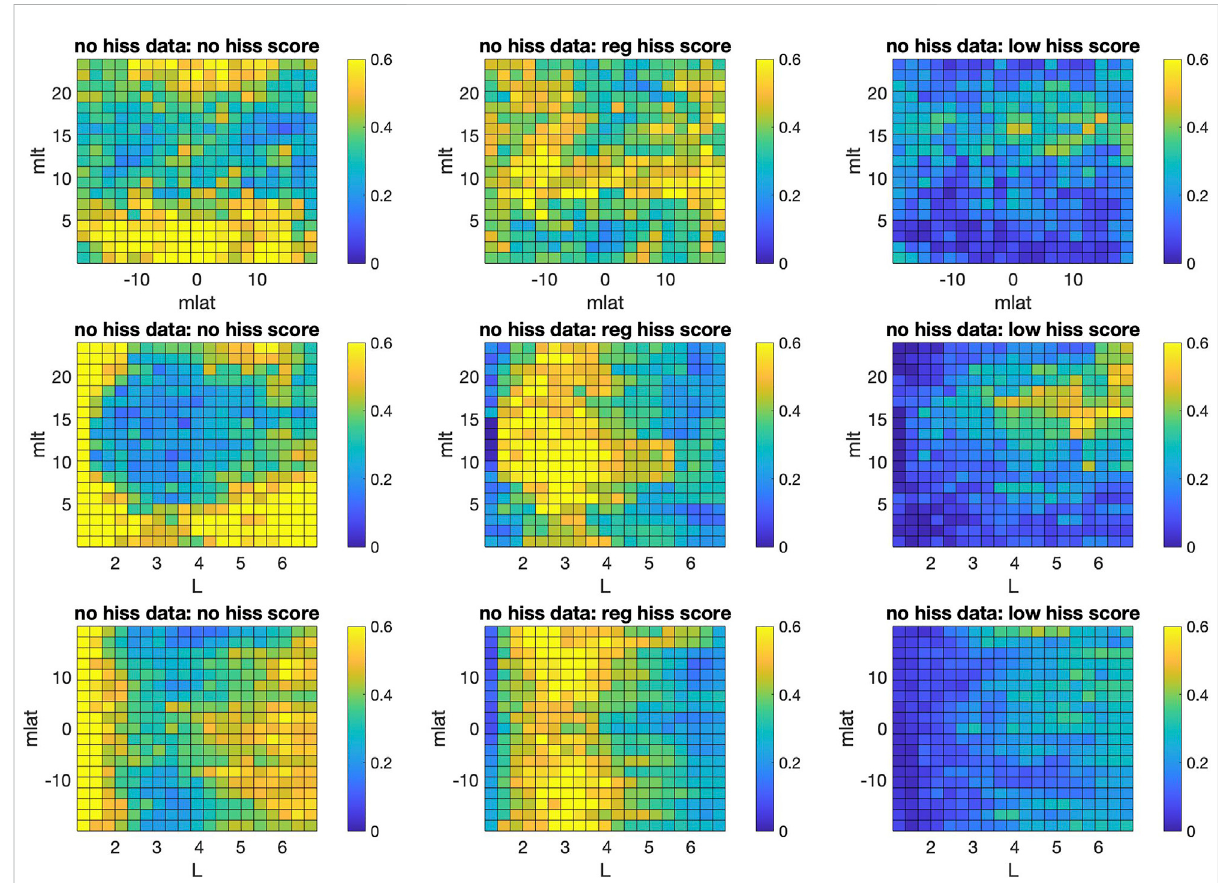
FIGURE 4 Partial dependence (Eq. 2) computed on the “ no hiss ” data points; color bar corresponds to the score of RF